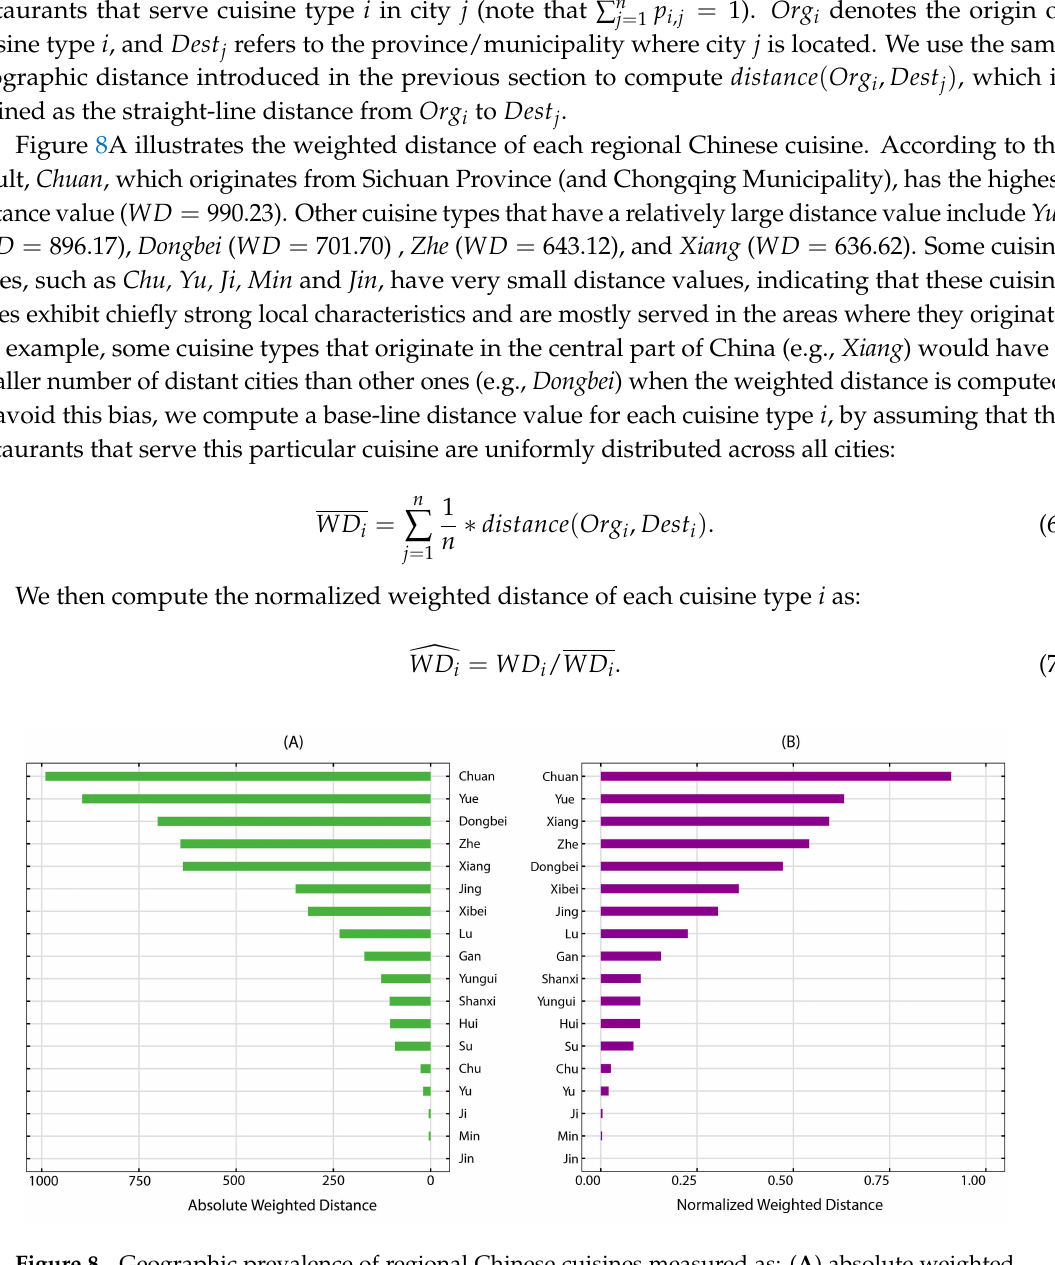
Figure 8. Geographic prevalence of regional Chinese cuisines measured as: ( A ) absolute weighted distance, and ( B ) normalized weighted